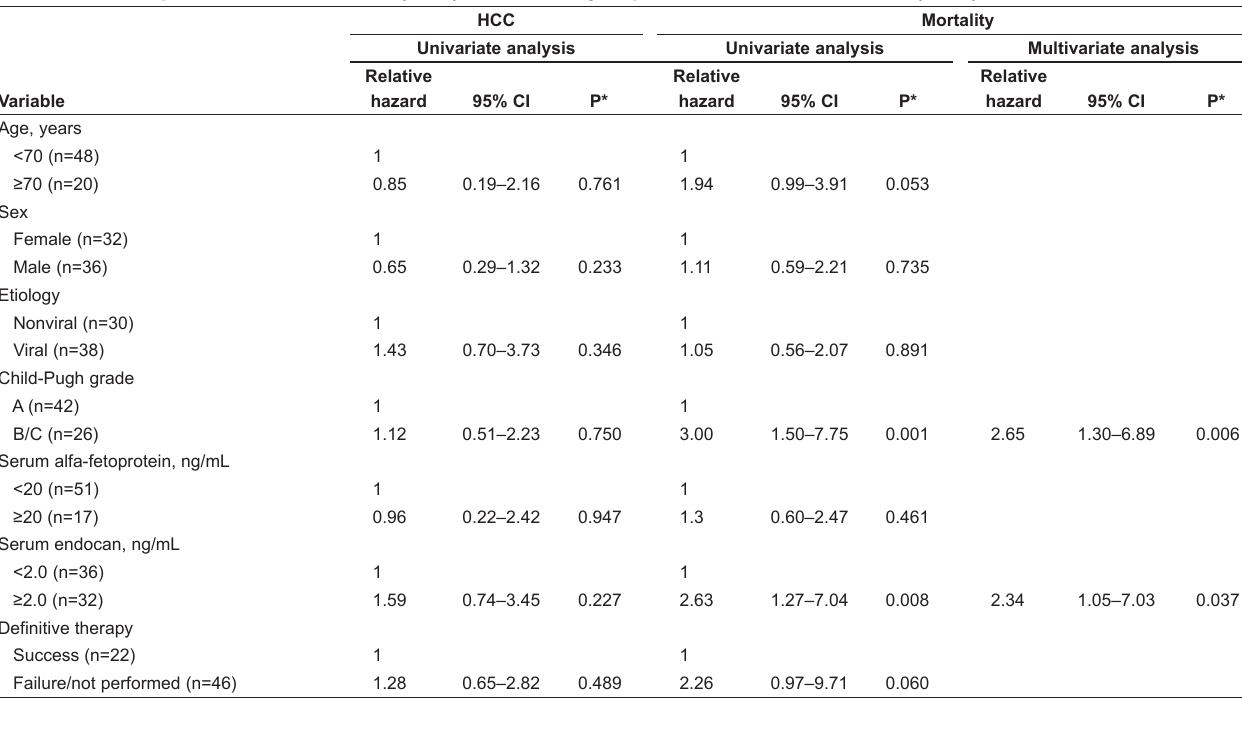
Table 2 Predictors of hepatocellular carcinoma (HCC) and mortality in patients with liver cirrhosis (n=68)